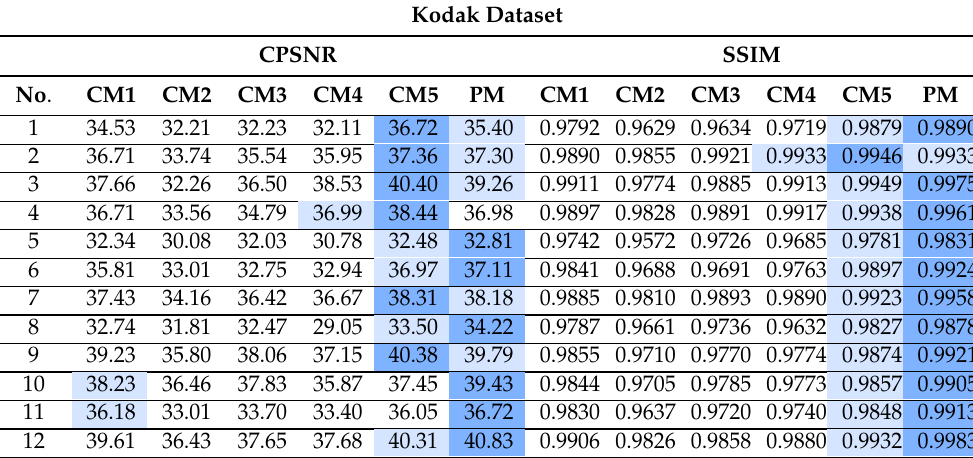
Table 1. Comparison of CPSNR(DB) and SSIM (Noise free) on the Kodak dataset. Kodak